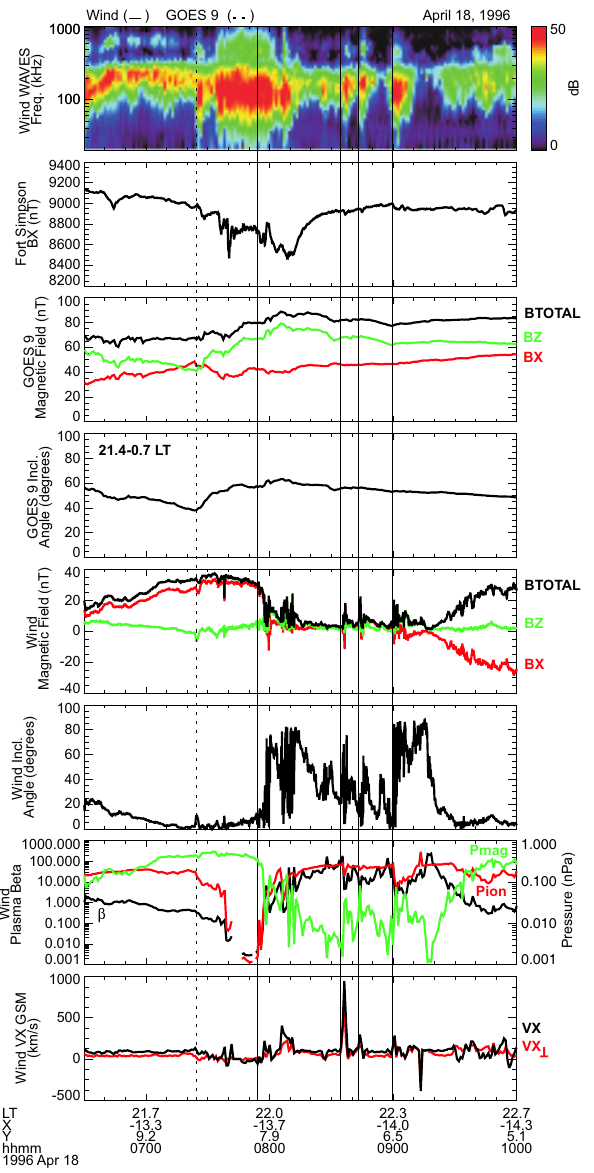
Fig. 3. Wind, CANOPUS and GOES 9 data from 06:30 to 10:00 UT on 18 April 1996. Figure 3 is the same format as Fig. 2, except that the X component of the magnetic field from Fort Simpson is shown in the second panel and data from the GOES 9 geosynchronous satellite are shown. GOES 9 was located between 21.4 LT to 0.7 LT for the time period shown in the